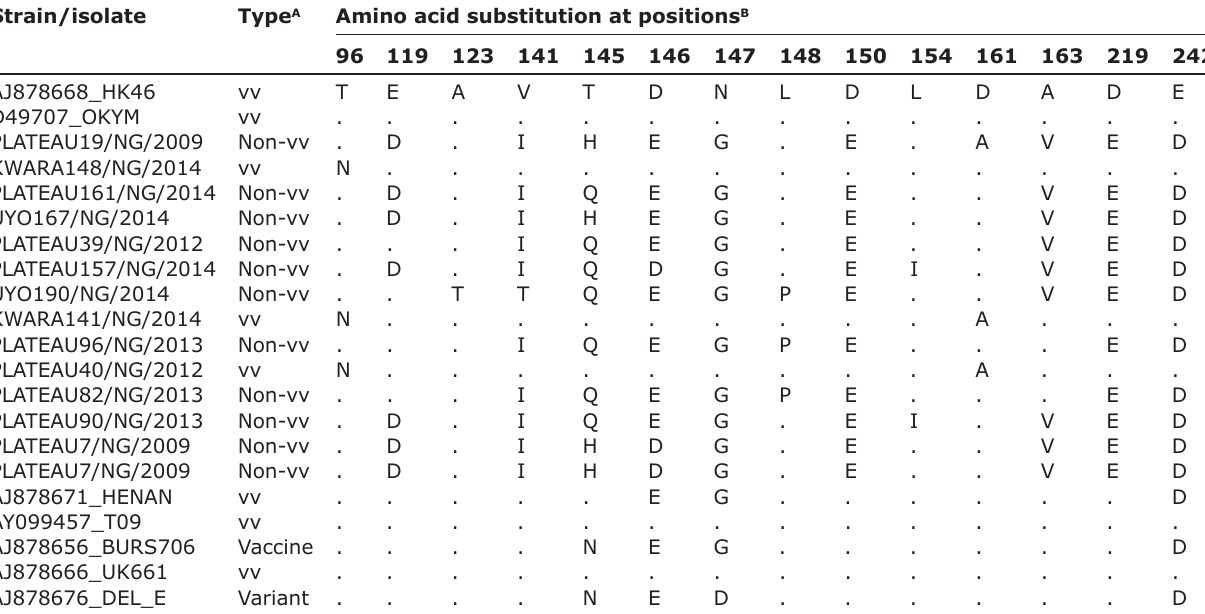
Table-2: Comparison of genome segment B amino acid substitutions at selected positions between Nigerian field viruses and published strains of IBDV.